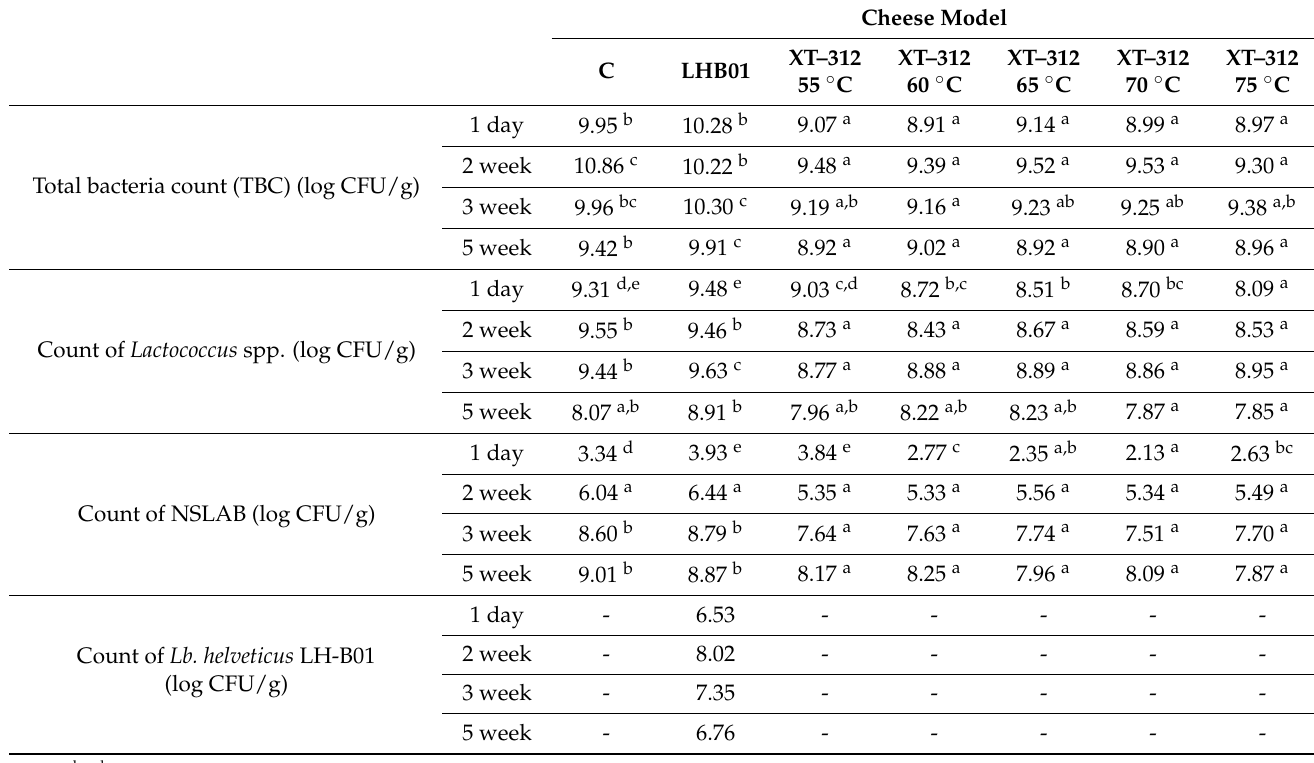
Table 4. Count of selected groups of bacteria in the analyzed cheese models during